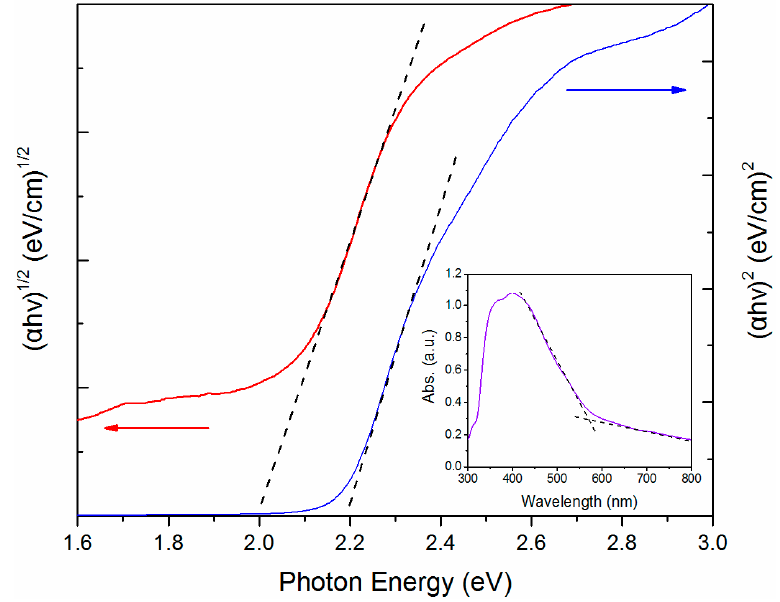
Figure 2. Tauc plots of hematite for determining the indirect (2.0 eV) and direct (2.2 eV) band gaps (Insert picture: UV–Vis absorption spectra for hematite electrode).